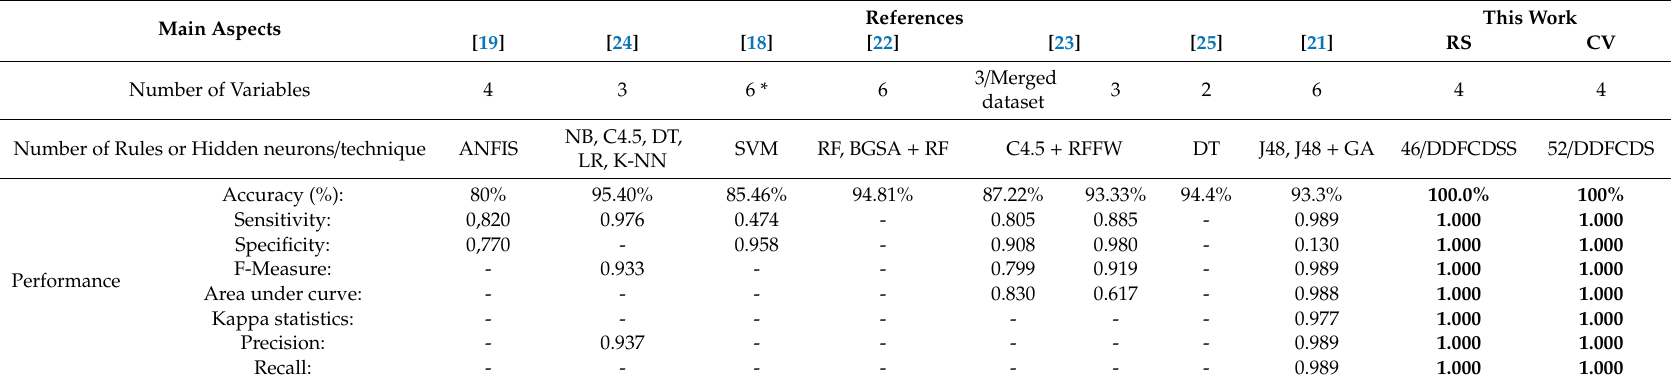
Table 11. Performance metrics obtained with our proposed framework and other classifiers obtained from the literature for Wart treatment (Cryotherapy) dataset. Main Aspects